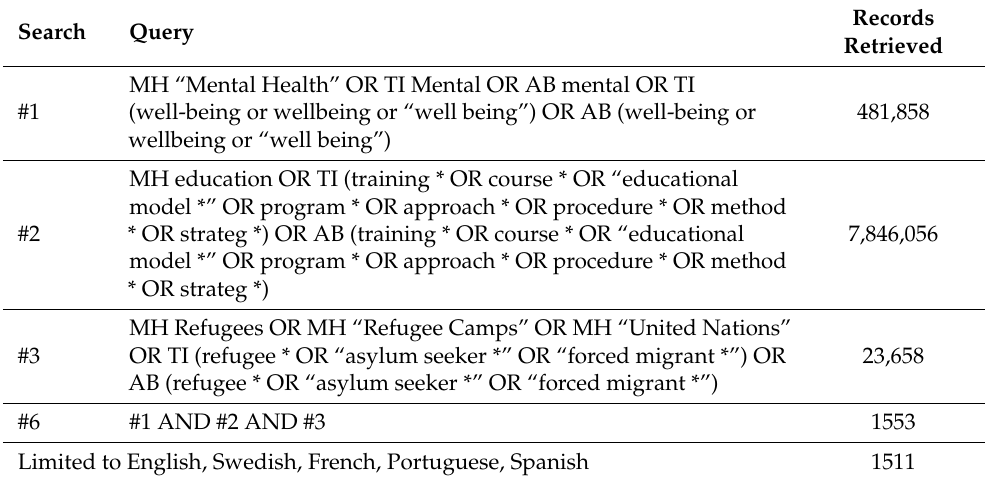
Table A1. Search Strategy for MEDLINE (EBSCO) Search conduct on 16 December